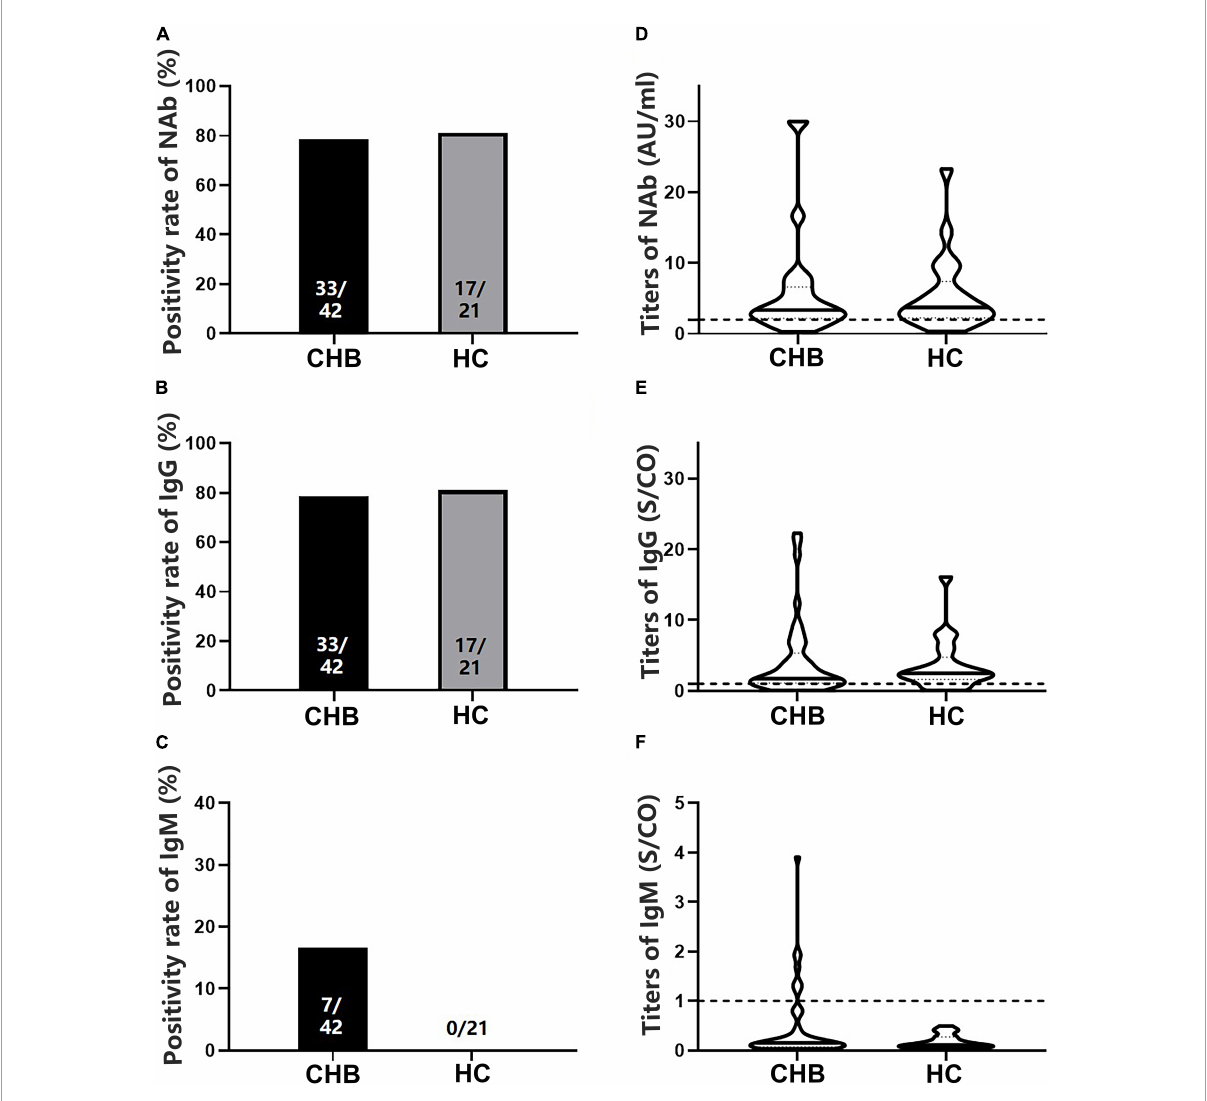
FIGURE2 Comparison of the positivity rates and titers of antibodies against severe acute respiratory syndrome coronavirus 2 (SARS-CoV-2) between patients with CHB and HCs. (A–C) Comparison of NAb, immunoglobulin G (IgG), and immunoglobulin M (IgM) positivity rates between the two groups. (D–F) Comparison of NAb, IgG, and IgM antibody titers between the two groups; n1/n2 in bars, positive cases/all cases; dotted line, cutoff value; CHB, chronic hepatitis B; HCs, healthy controls; NAb, neutralizing